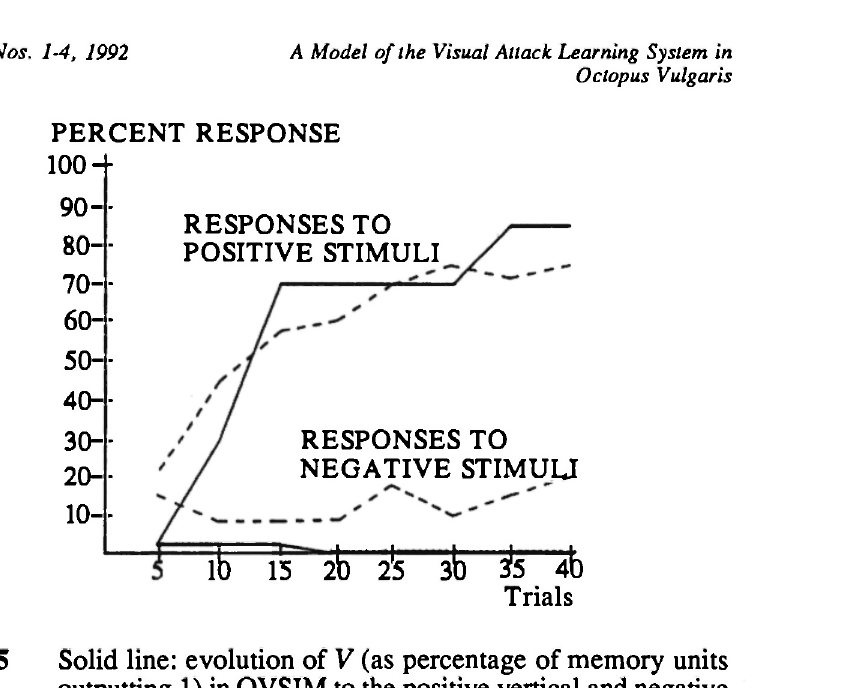
Fig. 5 Solid line: evolution of V (as percentage of memory units outputting 1) in OVSIM to the positive vertical and negative horizontal rectangle patterns, averaged over three simulations. Dashed line: percent attacks by Octopus as a function of trails for the same task (from (Young, 1964)); data averaged from 25 animals. All points are average of 5